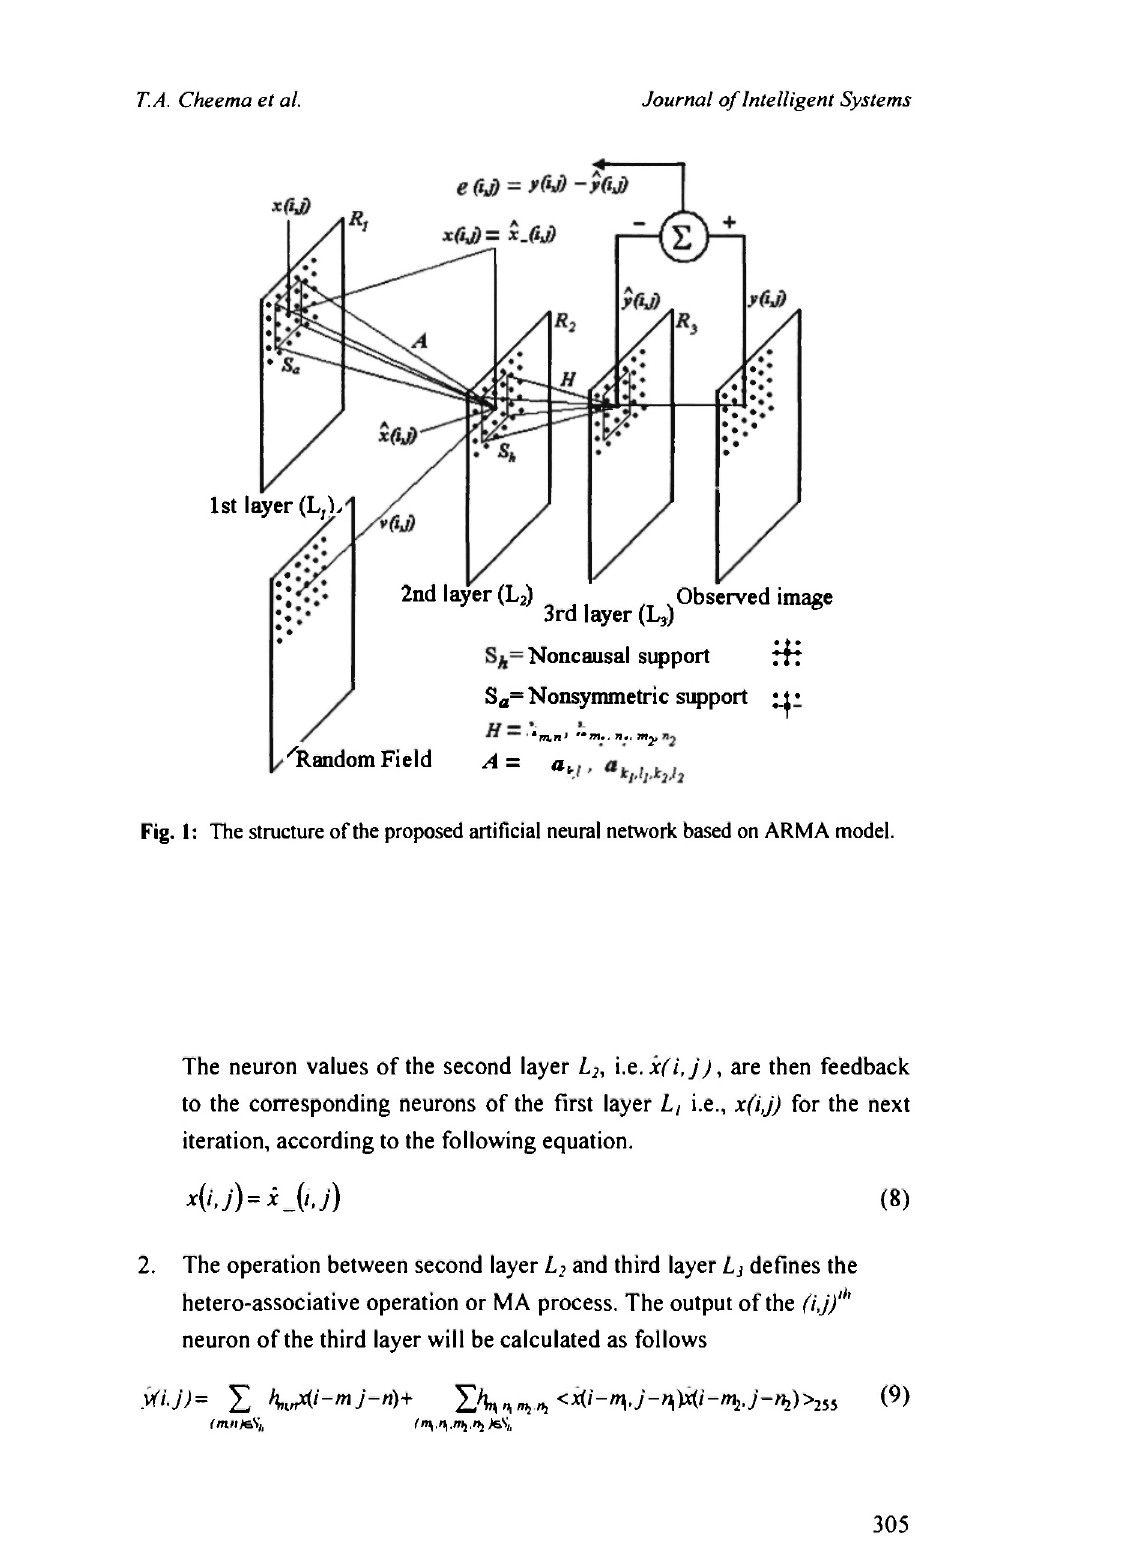
The neuron values of the second layer L 2 , i.e. x(i,j) , are then feedback to the corresponding neurons of the first layer L, i.e., x(i,j) for the next iteration, according to the following